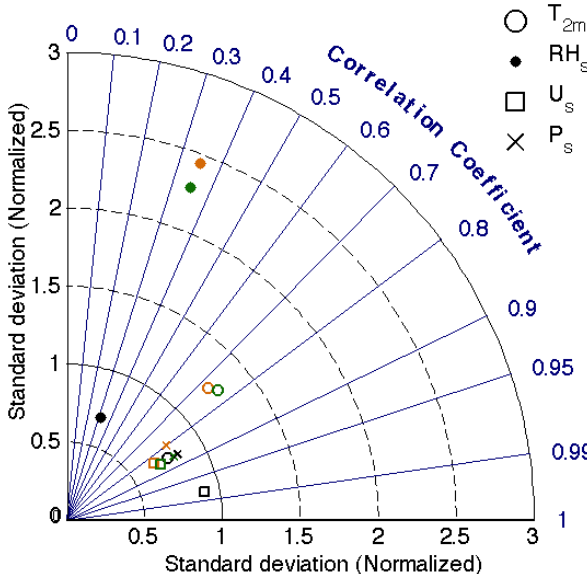
Fig. 6. Taylor diagram summarizing the normalized standard devia- tion and the correlation coefficient for each of the variables in Fig. 4. Note that the distance to unity at any given point is directly related to the root-mean-square error